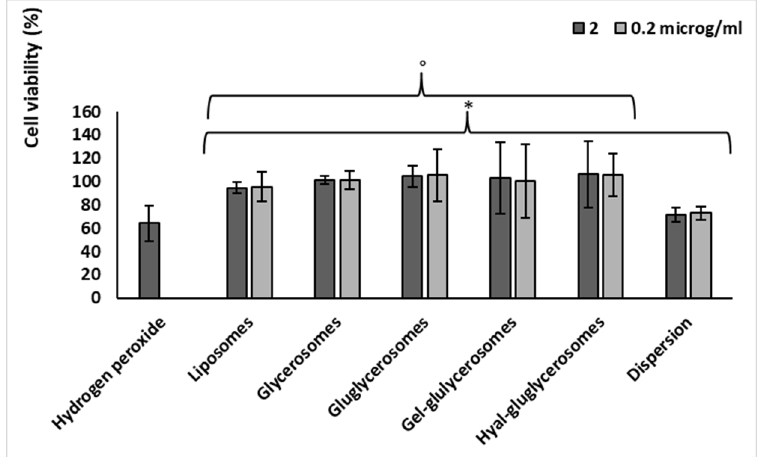
Figure 6. Viability of keratinocytes stressed with hydrogen peroxide and treated with H. scruglii extract in dispersion or loaded in vesicles. Data (bars) are reported as mean values ± standard deviations of cell viability expressed as the percentage of control (untreated cells; 100% of viability). The symbol (*) indicates values statistically different from that obtained with hydrogen peroxide ( p < 0.05); (°) indicates values statistically different from that obtained with dispersion ( p < 0.05).